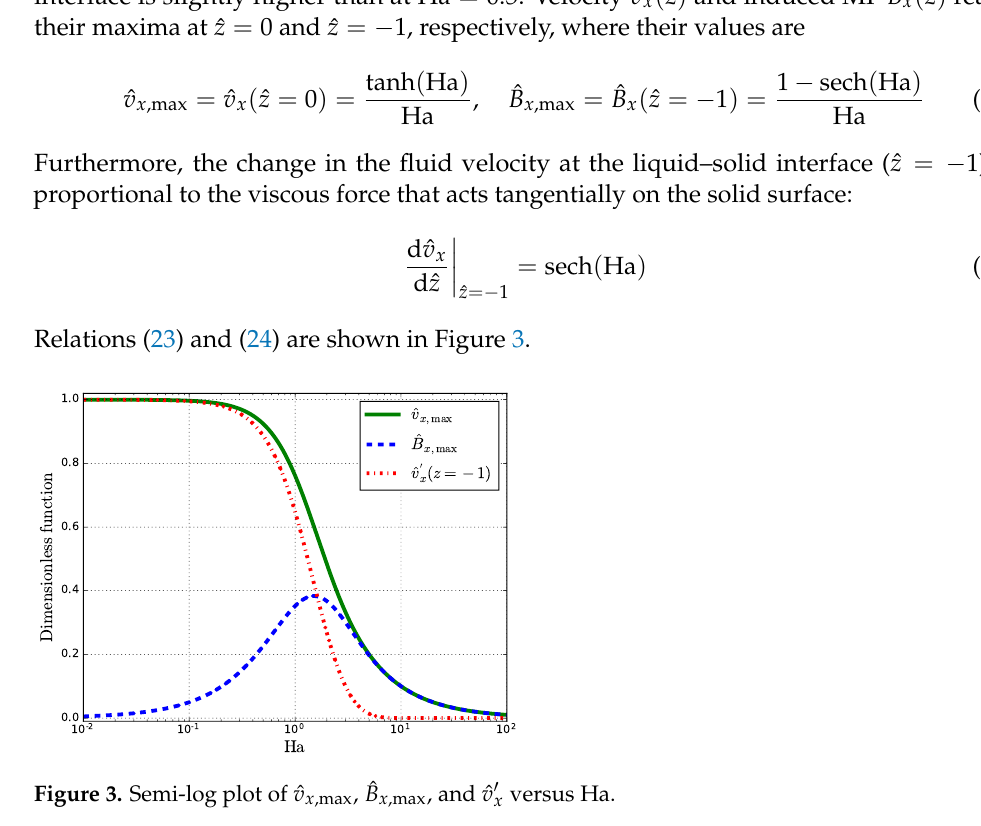
Figure 3. Semi-log plot of ˆ v x ,max , ˆ B x ,max , and ˆ v (cid:48) x versus Ha. Since ˆ v x ,max is a monotonically decreasing function of Ha, it should be inferred that the induced Lorentz force, regardless of its strength, has a damping effect and brakes the fluid flow. The behavior of the induced MF near Ha = 1 (Figure 2b) can be explained by reaching a maximum with a subsequent drop. For small Ha, the maximum induced MF ˆ B x ,max is Ha/2 that gives the following relation to the external static MF B 1